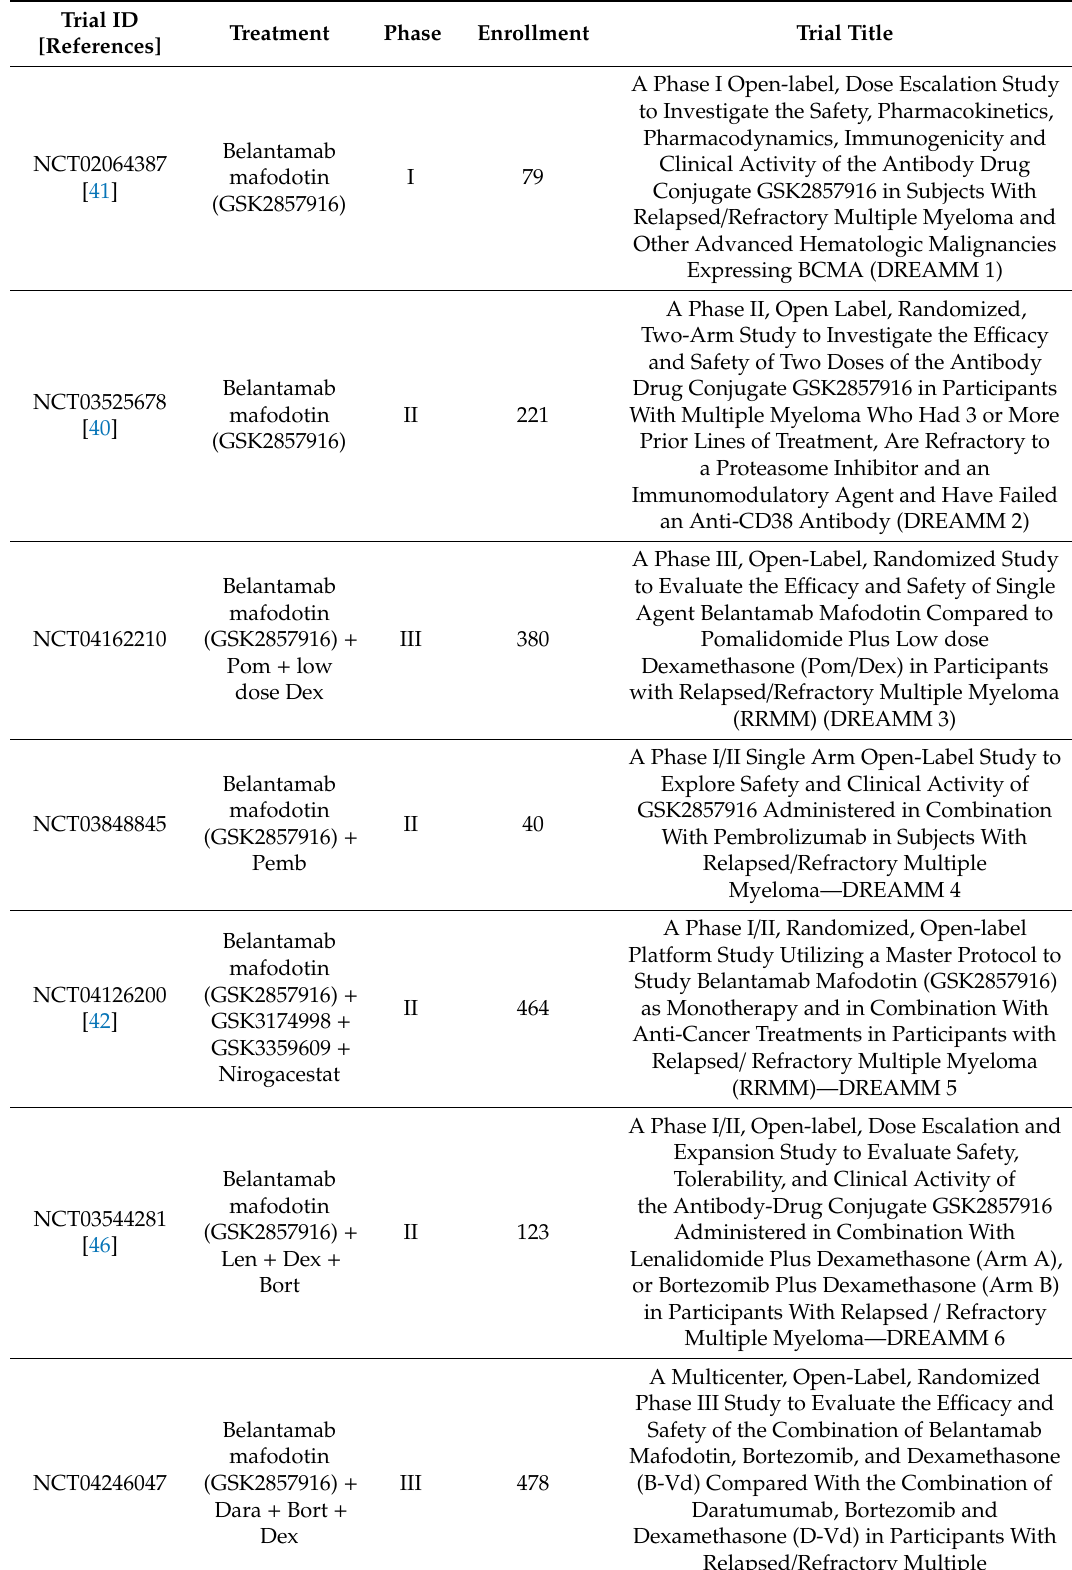
Table 1. Active trials of anti- B cell maturation antigen (BCMA) monoclonal antibodies and their drug conjugates in relapsed / refractory multiple myeloma